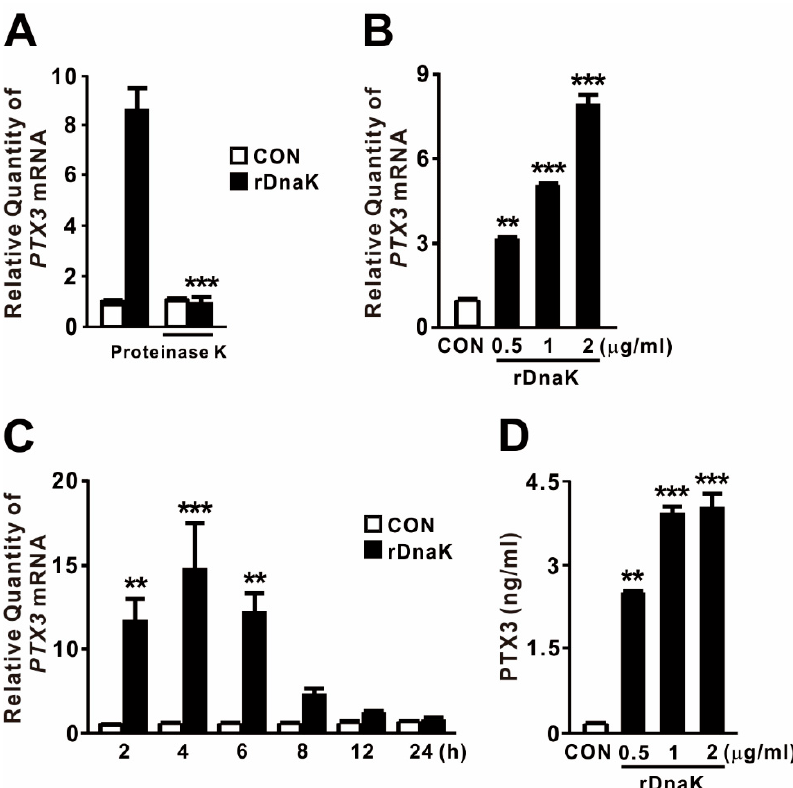
Figure 1. P. aeruginosa -derived DnaK increases the production of PTX3. ( A ) Recombinant P. aeruginosa DnaK (rDnaK) was pretreated with proteinase K (20 µ g/mL) for 1 h, followed by the treatment of dTHP-1 cells with rDnaK (0.5 µ g/mL) for 4 h. ( B – D ) The dTHP-1 cells were treated with the indicated concentrations of rDnaK for either 4 h ( B ) or 24 h ( D ), as well as with 0.5 µ g/mL rDnaK for the indicated time ( C ). After treatment, the level of PTX3 expression was quantified by either qRT-PCR or ELISA. Data in ( A – D ) are expressed as mean ± SD ( n = 3). ** p < 0.01; *** p < 0.001 vs. no treatment ( A ) or CON ( B – D ).